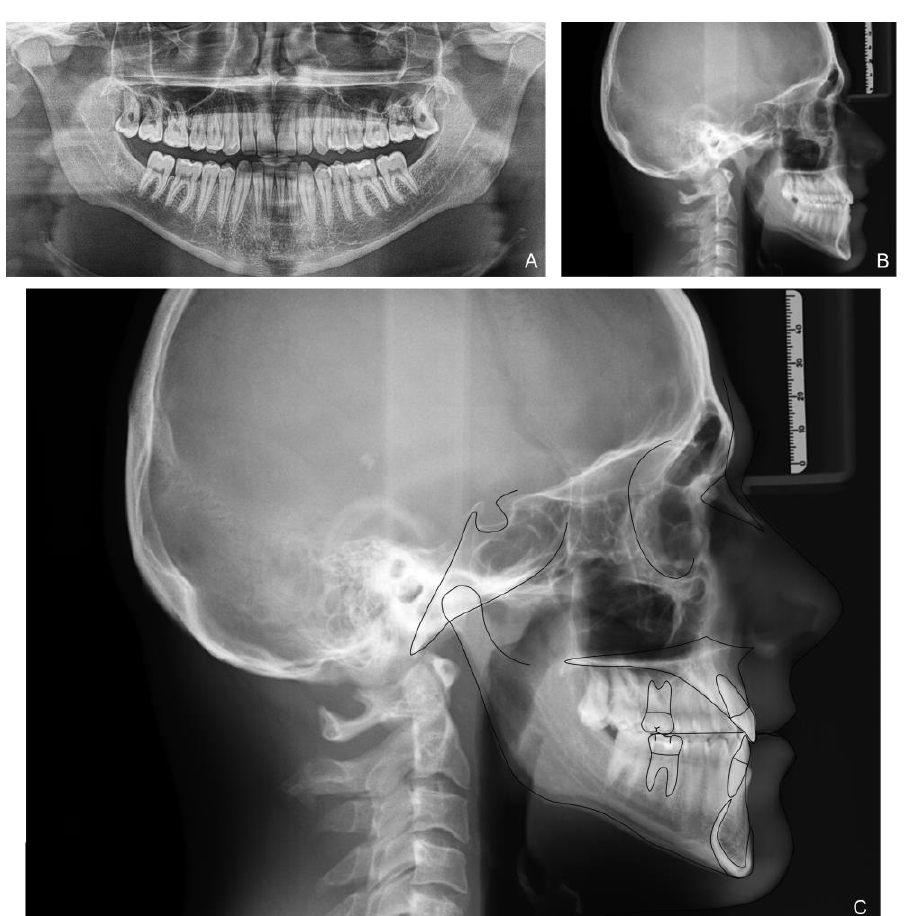
Figure 6. Intra and extra-oral pictures of the patient at the end of treatment: Right lateral occlusion ( A ); Frontal occlusion ( B ); Left lateral occlusion ( C ); Upper arch ( D ); Lower arch ( E ); Patients smile ( F ) and profile ( G ).